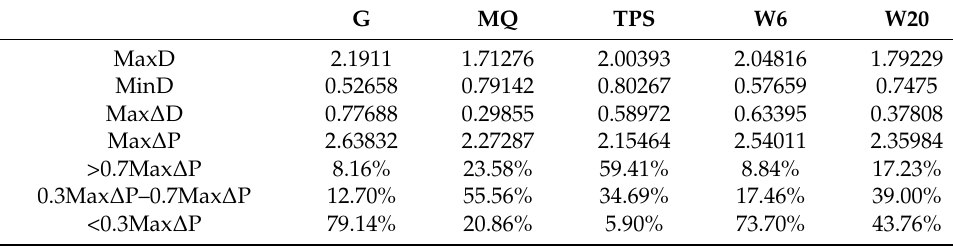
Table 5. Comparison of the modification results.